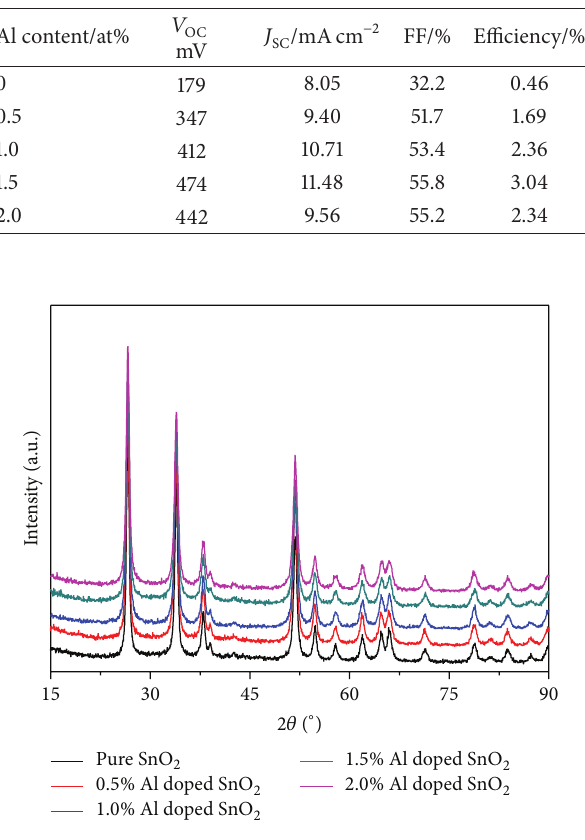
Figure 2: XRD of SnO 2 hollow microspheres doped with different Al